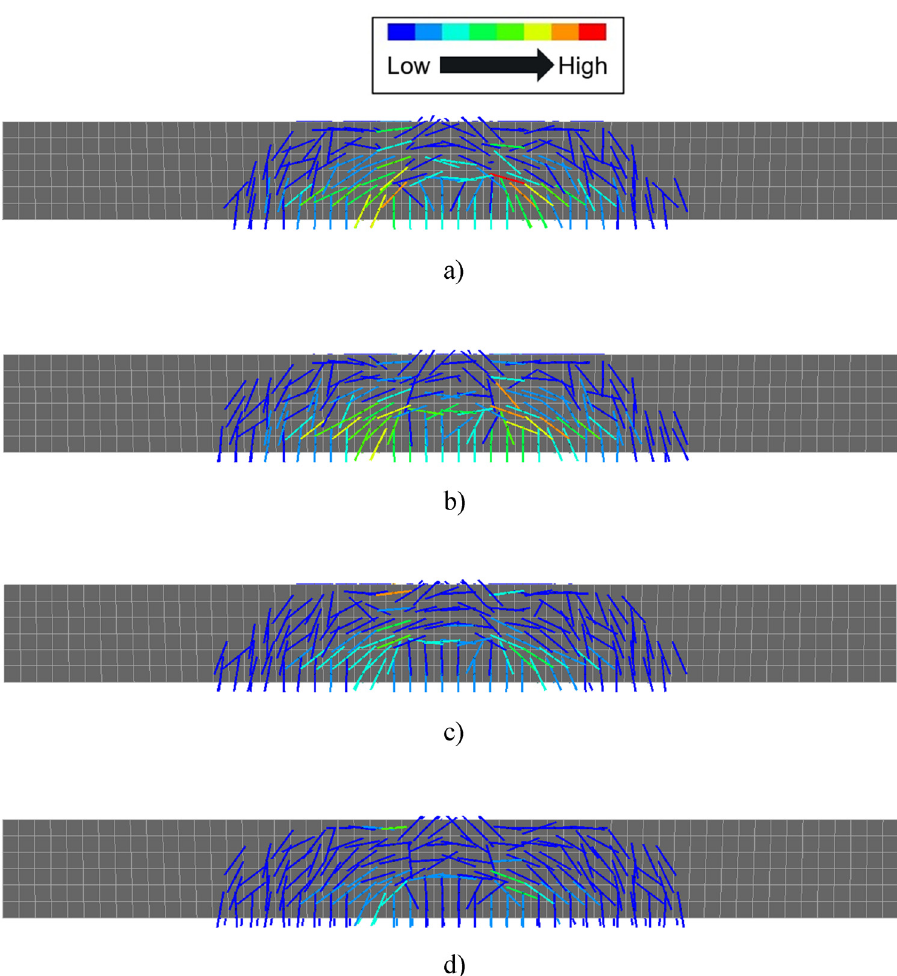
Figure 17: Crack images of beam reinforced with CNTFPC rebars. ( a ) CNT weight ratio of 0.00, ( b ) CNT weight ratio of 0.01, ( c ) CNT weight ratio of 0.02, and ( d ) CNT weight ratio of 0.04.